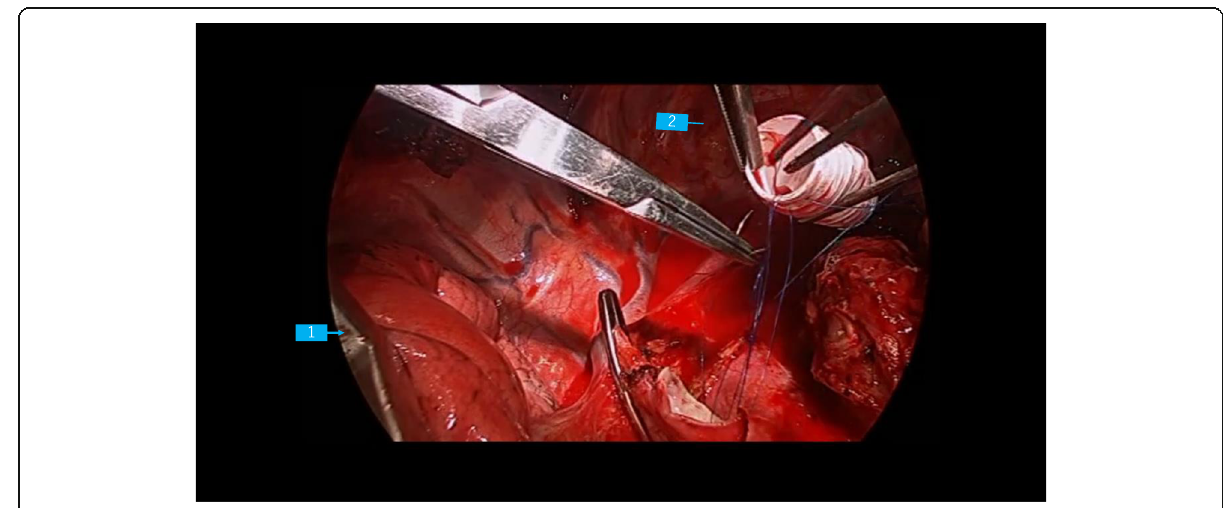
Fig. 4 Intraoperative thoracoscopic view. The main procedure of superior vena cava (SVC) replacement that was performed during selective blockade of the right upper lung lobe using a bronchial blocker. Arrow 1, collapsed right upper lobe; arrow 2, artificial vessel that was used to replace the superior vena